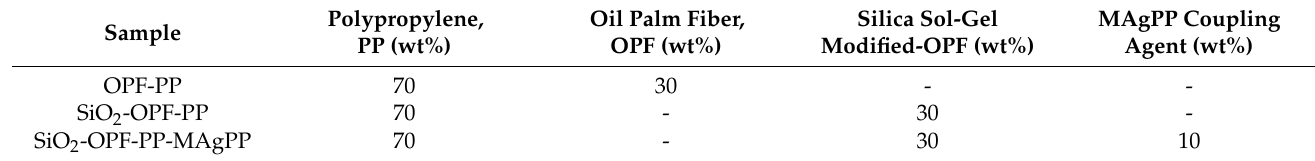
Table 2. Compounding formulation of